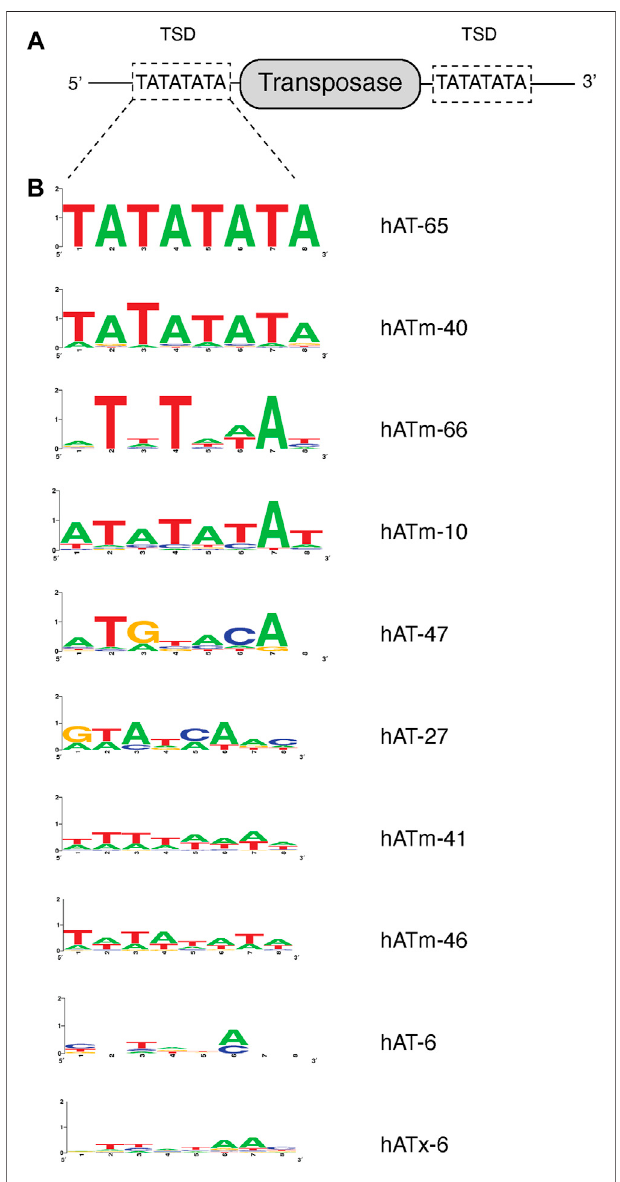
FIGURE2| Predicted target site preference of transposable elements. (A) Schematic representation of the 8 nt target site duplication (TSD). Flanking DNA sequences of predicted transposases within the genome areanalyzedandtheTSD at5 ′ and3 ′ ofthetransposaseareidenti fi ed. The TATATATA TSD of hATm-3 is shown as an example. (B) Predicted 8 nt TSD of various transposases in order of TSD sequence bias shown as